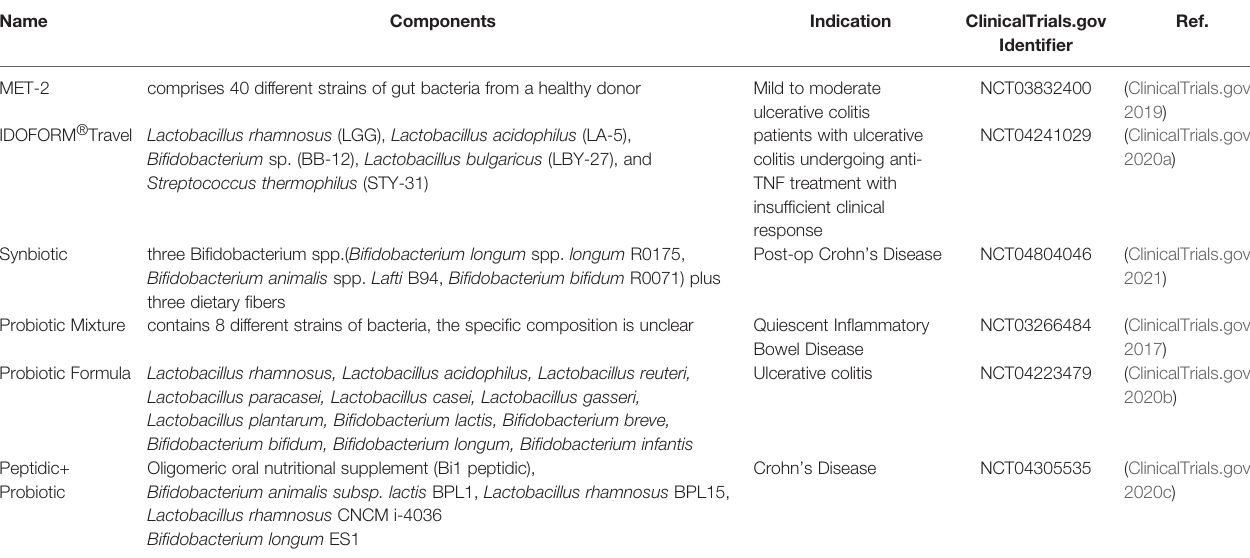
TABLE 1 | Ongoing clinical trials of arti fi cial consortium transplantation